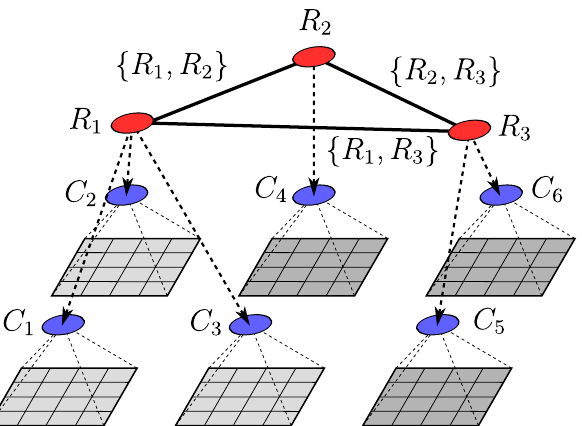
Figure 5. Hierarchy created by the superpixel algorithm, showing individual pixels, pixel clusters ( C 1 , C 2 , C 3 , C 4 , C 5 , and C 6 ), and superpixel regions ( R 1 , R 2 , and R 3 ), where the regions are the graph verticies interconnected with graph